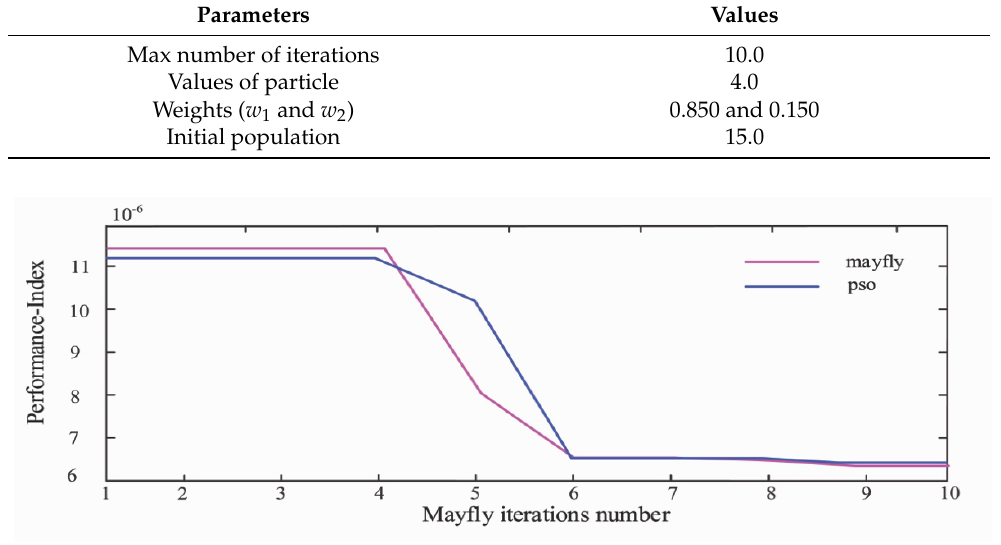
Figure 16. The performance index of PSO for the 10 iterations.